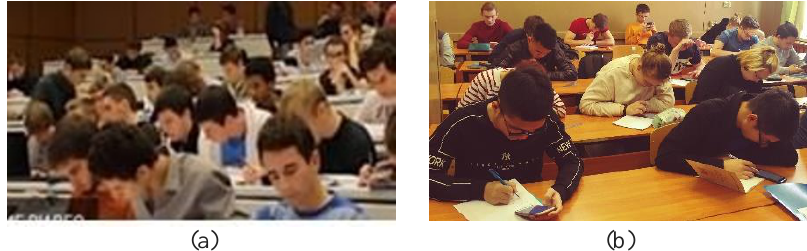
Fig. 5. Classroom work in blended learning environment: (a) École Polytechnique Fédérale de